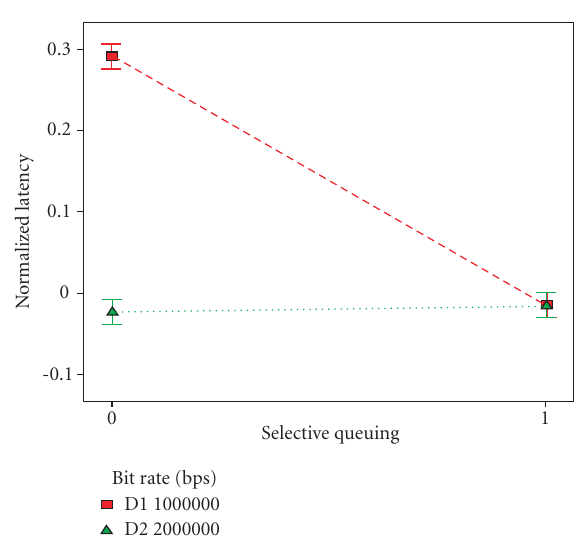
Figure 16: Analysis of selective queuing and data rate’s impact on VOIP